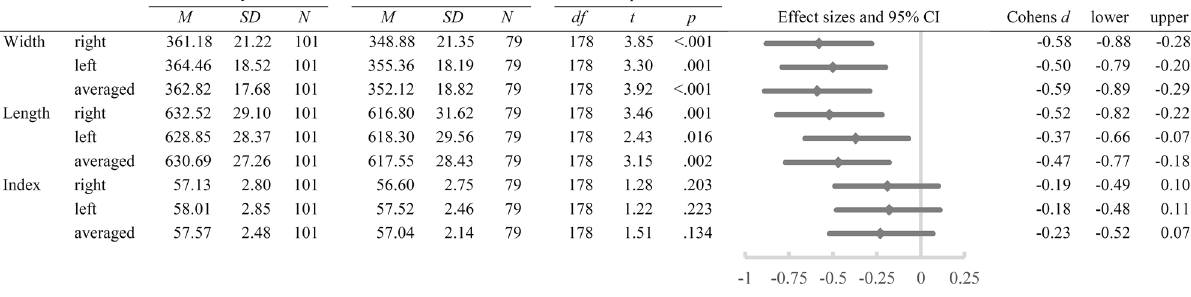
Table 5. Means, standard deviations, post-hoc t -tests, and effect sizes for sex differences in hand width, length and index of both hands ( N = 180).